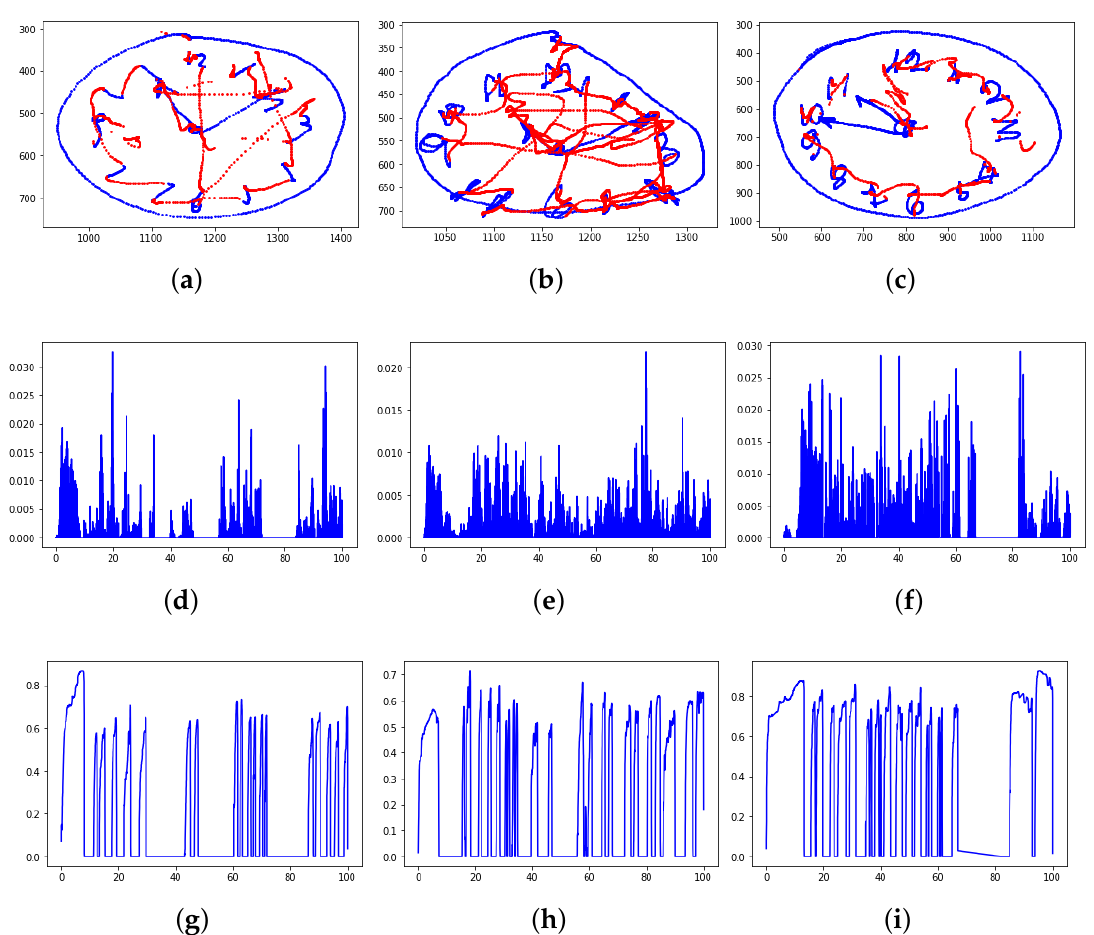
Figure 2. Clock drawing test (CDT) performed by a healthy control, a PD patient, and an mild cognitive impairment (MCI) subject: From top to bottom are the rendered task (the on-surface movement is in blue color; the in-air movement is in red), the velocity profile, and the pressure profile. It is recognizable how the PD patient tends to alter the figure dimensions, while the MCI subject missed the correct time. The velocity and pressure profile show more peaks, highlighting a movement which is characterized by less fluency and more changes of direction than the healthy handwriting. (Data have been acquired within the Handwriting Analysis against Neuromuscular Disease project—http://hand-project.di.uniba.it/). ( a ) Healthy CDT, ( b ) PD CDT, ( c ) MCI CDT, ( d ) healthy velocity, ( e ) PD velocity, ( f ) MCI velocity, ( g ) healthy pressure, ( h ) PD pressure, and ( i ) MCI pressure.